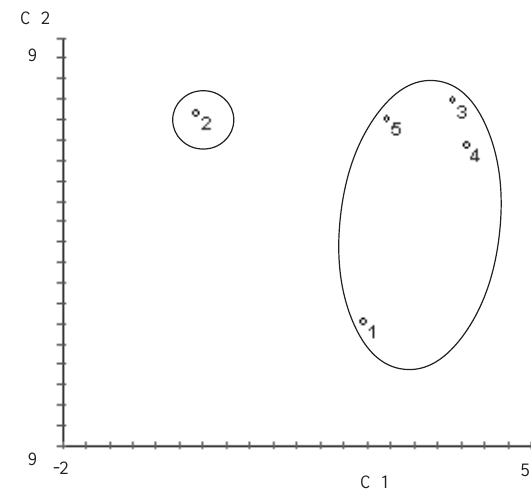
Figura 7. Dispersão gráfica das coberturas vegetais em relação aos dois primeiros componentes principais, com base nas variáveis do solo na época do inverno. 1- Eucalipto, 2- Floresta não preservada, 3- Floresta preservada, 4- Capoeira, 5- Pasto. C1- componente